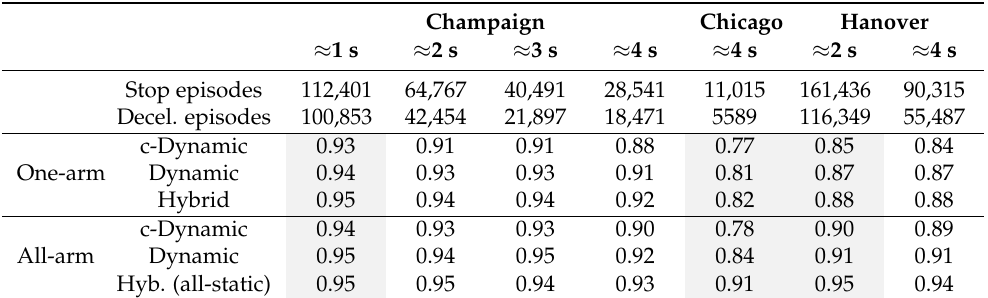
Table 6. Classification accuracy of TRR methods under different sampling rates (undersampling). The original datasets are highlighted in